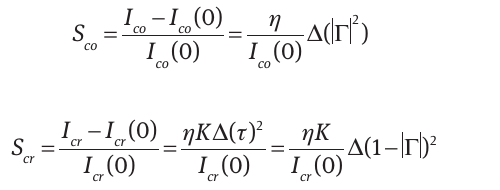
contains the signals and motional noises for each polarization. Black dashed arrows and solid arrows indicate the directions of the incident beam and the reflected beam, respectively, from the